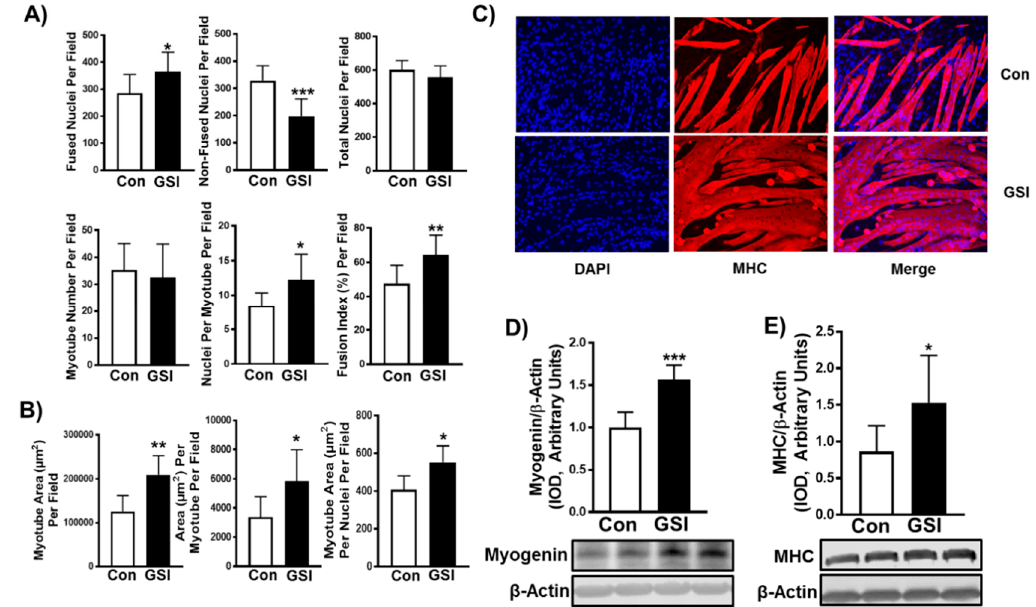
Figure 2. GSI increases myotube formation in differentiating C2C12 myotubes . ( A ) Indices of myotube fusion. Graph order, top left to right: Fused nuclei per field, Non-fused nuclei per field, and Total nuclei per field. Graph order, bottom left to right: Myotube number per field, Nuclei per myotube per field, Fusion index per field. ( B ) Indices of myotube hypertrophy. Graph order: Myotube area ( µ m) per field, Area ( µ m) per myotube per field, Myotube area ( µ m) per nuclei per field. ( C ) Representative image of 96-h myotubes co-stained with myosin heavy chain (MHC:red) and DAPI:blue. Images were taken at 20 × magnification and the scale bar = 50 µ m. ( D ) Myogenin / β -Actin; ( E ) MHC / β -Actin expression (Integrated optical density, IOD) in 96-h myotubes treated with or without 4 µ m γ -secretase inhibitor (GSI) every 12 h. For Western blot representative images: lanes 1 and 2 are Con; lanes 3 and 4 are GSI. Thirty minutes prior to collection all cells were treated with 1 µ m puromycin. Data were analyzed using a Student’s T-test. * p ≤ 0.05 vs. Control (Con); ** p < 0.01 vs. Con; *** p < 0.001 vs. Con ( n = 3 experiments). Data are mean ± SD.